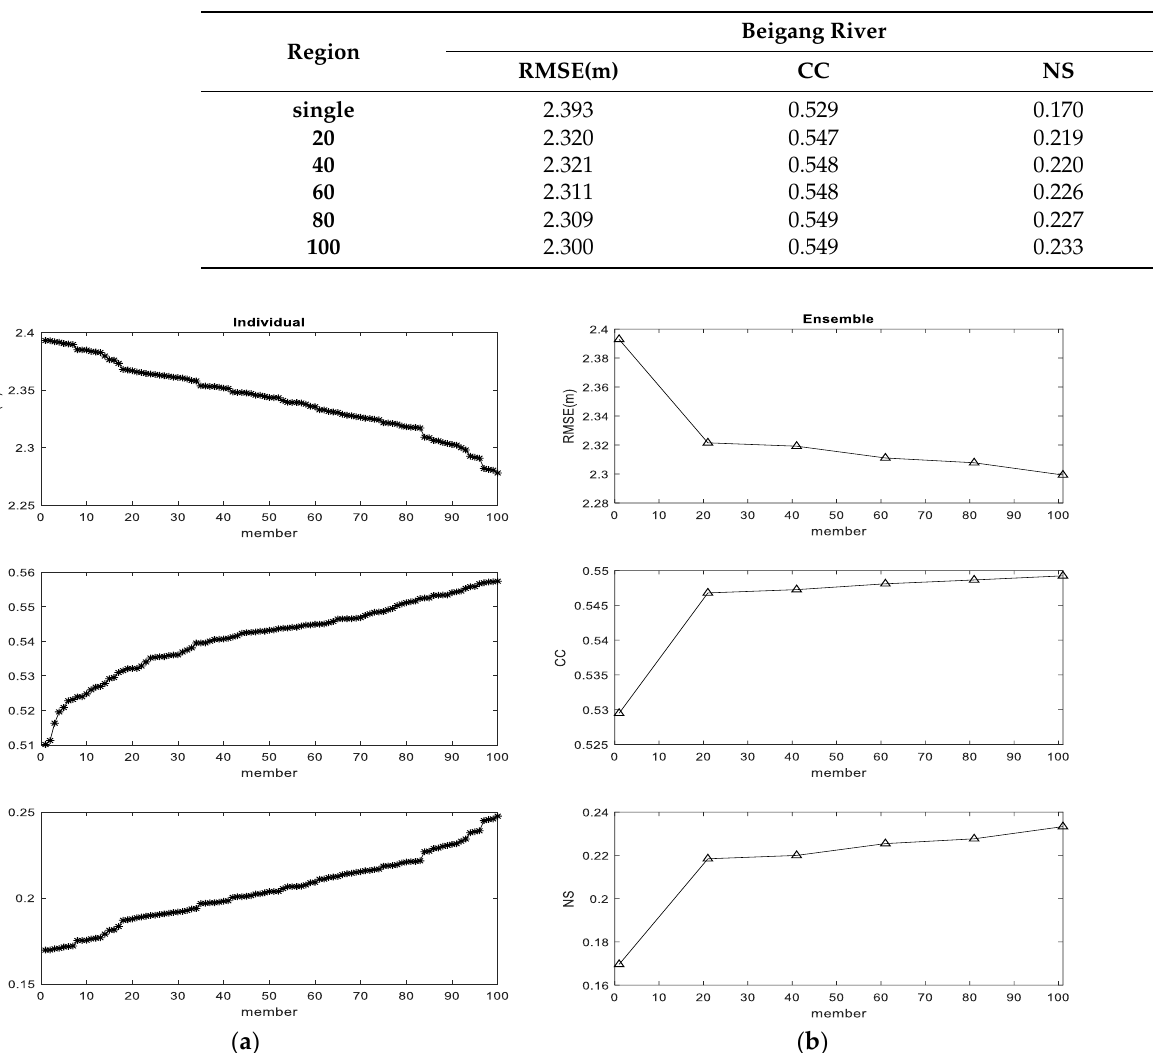
Table 3. Performance by different ensemble size in Beigang River.